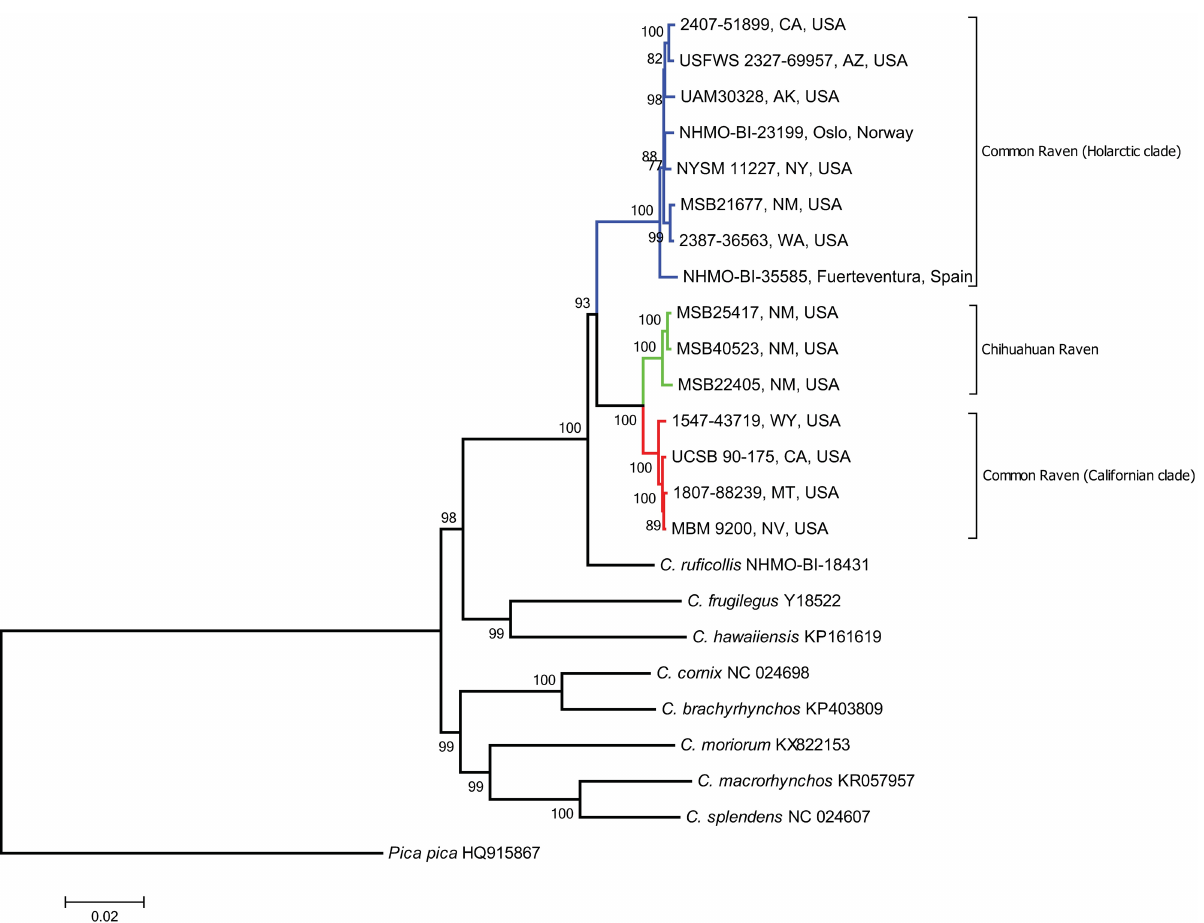
Fig 3. Maximum likelihood phylogeny inferred from whole mitogenomes of three species of ravens (common raven C . corax , Chihuahuan raven C . cryptoleucus , brown-necked raven C . ruficollis ), and six other Corvus species with published mitogenomes (labeled with GenBank acc. no.). The final dataset used in the phylogenetic analysiscontained15,392 bp after indelsand positionsin the alignmentwith less than 95% coveragewere eliminated. The tree was rooted with Pica pica . USA = United States of America, CA = California,AZ = Arizona, AK = Alaska, NY = New York, NM = New Mexico, WA = Washington, WY = Wyoming, MT = Montana, NV = Nevada.